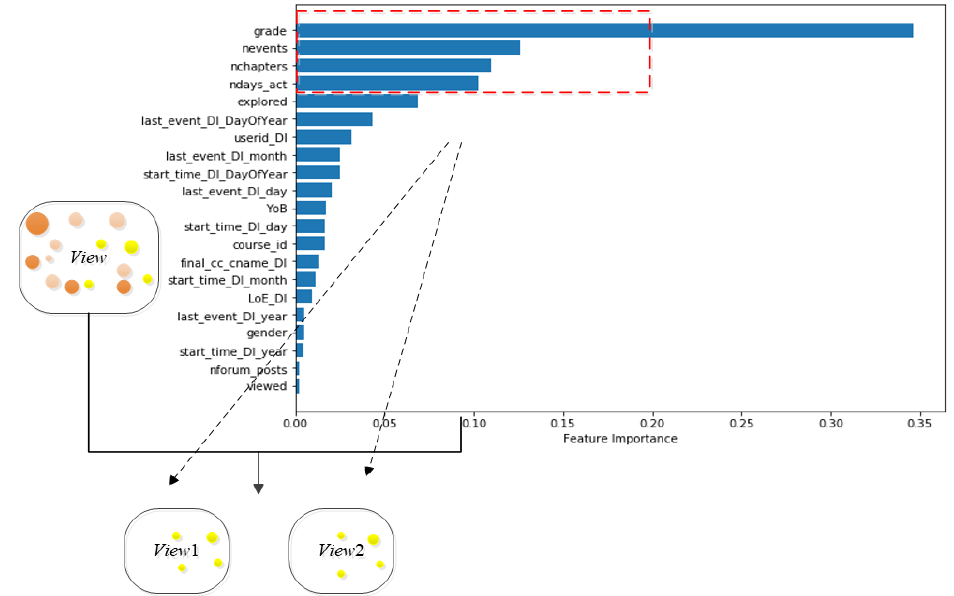
Figure 2. The selection of shared features. Orange parts: the important features, which are selected by feature importance; blue and green parts: the remaining features.